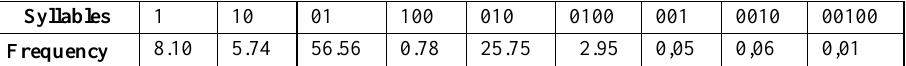
Table 2. Frequency of syllables in a character record